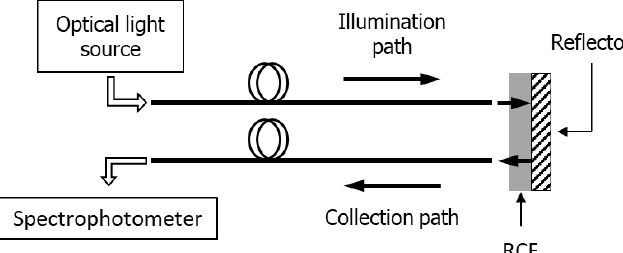
Figure 36. Typical schematic of an optical fiber based RCF reading method. Adapted with permission from Elsevier from Ref. [177] (the figure is released under a Copyright Clearance Center’s RightsLink ® service, Copyright © 2019).